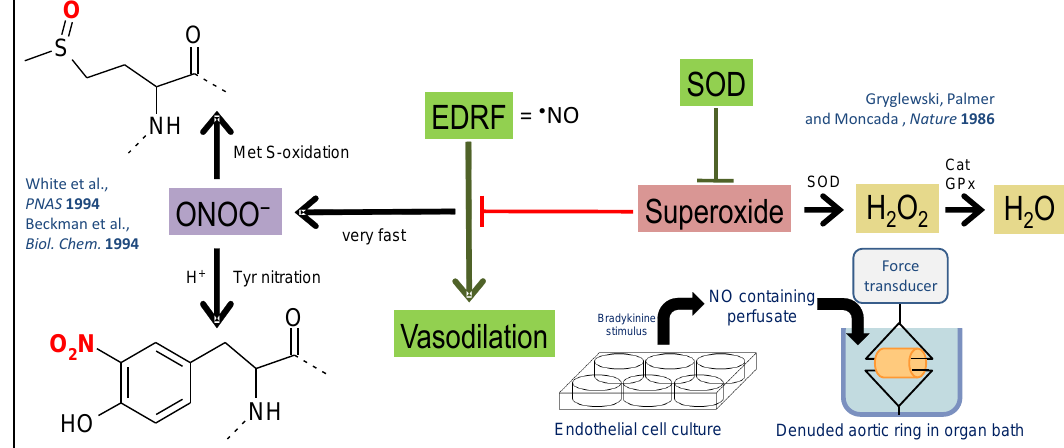
Figure 1. Overview on the simplified model of redox biology in the vascular system. O 2 • ¯ was identified as an antagonist of the EDRF (see red inhibitory bar), far before EDRF was widely accepted to be • NO by the famous experiment of Gryglewski, Palmer, and Moncada based on the transfer of the perfusate from bradykinin-stimulated endothelial cell culture to an organ bath with denuded (endothelium-devoid) aortic ring segments [44]. The vasodilatory potency of EDRF coming from the cell culture was increased by addition of SOD to the buffer on the cells conferring dismutation of O 2• ¯ (see green inhibitory bar), supporting the break-down of EDRF by O 2• ¯. From previous work, we know today that • NO and O 2• ¯ react in a diffusion-controlled reaction to form ONOO¯ [30,31]. Without this reaction, O 2• ¯ is dismutated either by SODs or undergoes spontaneous self-dismutation to form H 2 O 2 , which is largely involved in redox signaling pathways via oxidation of specific thiol residues, or inactivated by catalases (Cat), GPx, or peroxiredoxins (Prx). ONOO¯ can cause widespread oxidative damage in proteins (tyrosine nitration [3-NT] and methionine sulfoxidation [oxMet]) but also lipids and DNA molecules [54]. Scheme is modified from [41] with permission.